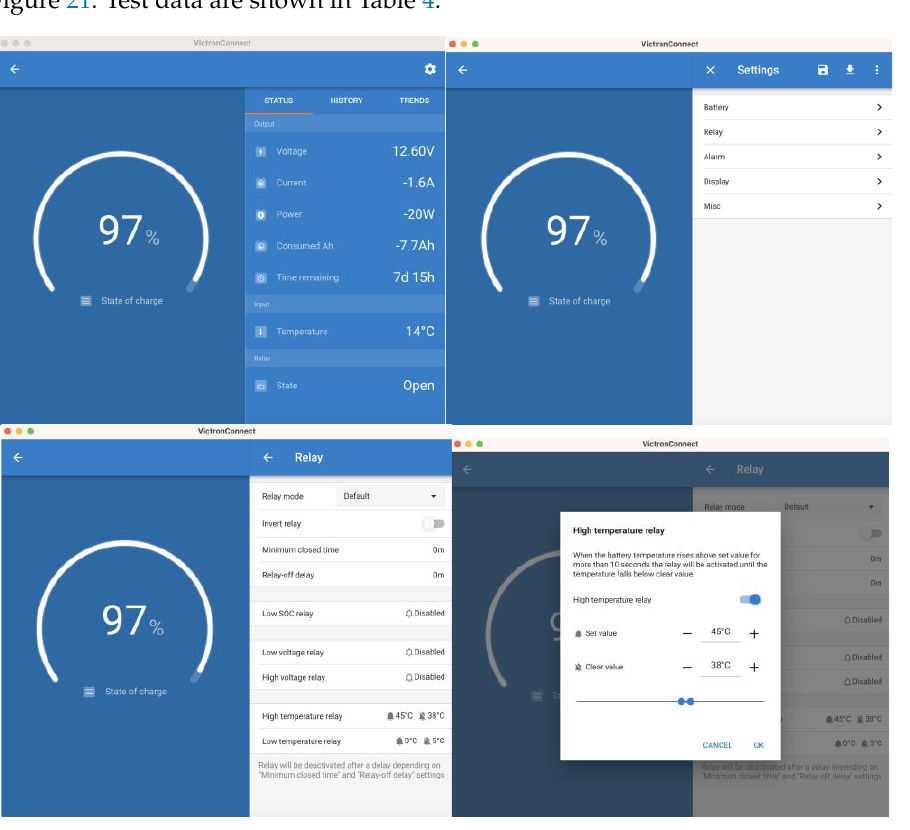
Figure 21. Configuration of conditions based on temperature sensor and relay of the BMS-712.